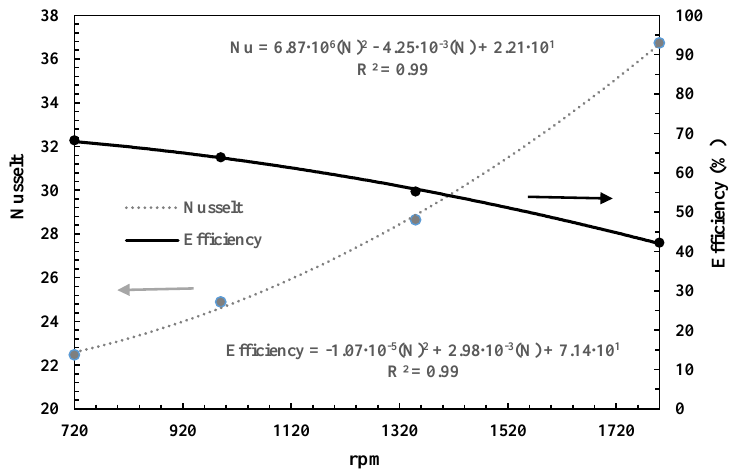
Figure 19. Nusselt number and efficiency variation with the rotating speed of the fan. N = rpm.